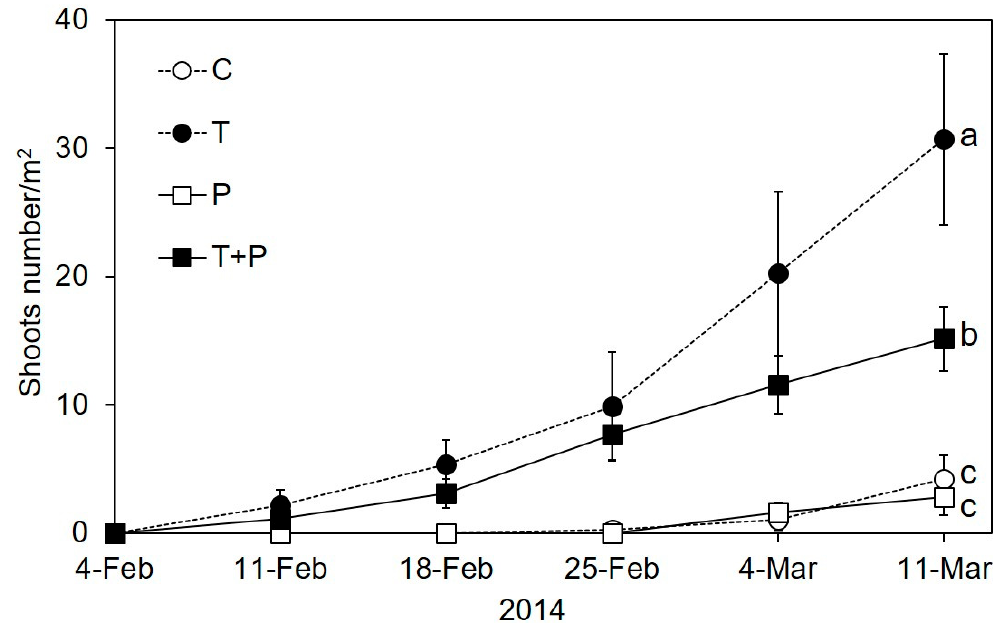
Figure 2. The average number of P. crispus shoots during the experiment in 2014. Abbreviations used: control, C; water temperature was increased 4.5 ◦ C compared with the control, T; addition of 50 µ g L − 1 phosphate every 2 weeks, P; addition of 50 µ g L − 1 phosphate every 2 weeks and temperature increase of 4.5 ◦ C, T + P. Different letters (a, b, c) indicate significant ( p < 0.05) differences. Error bars indicate ± standard error (SE).